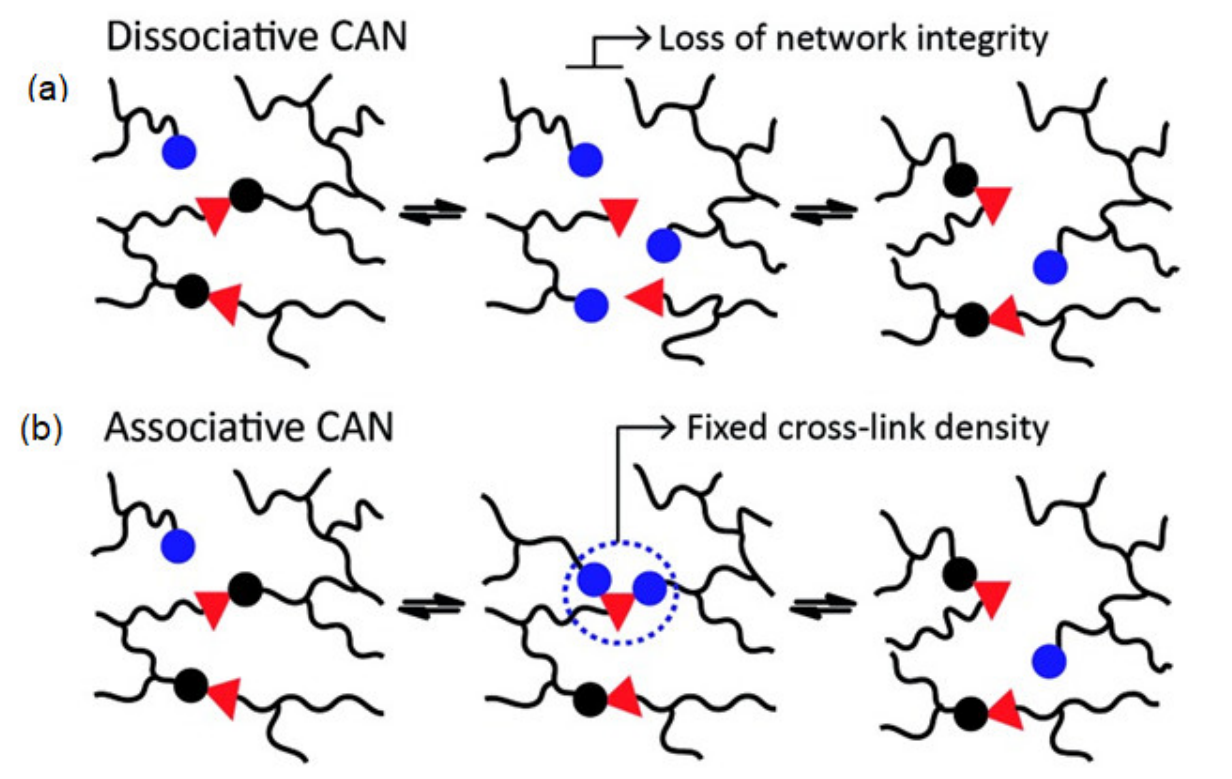
Figure 2. Dissociative ( a ) and associative ( b ) CANs based on exchange reactions and occurring, respectively, with or without a temporary loss of crosslink density. Reproduced from [43]. with permission from the Royal Society of Chemistry.